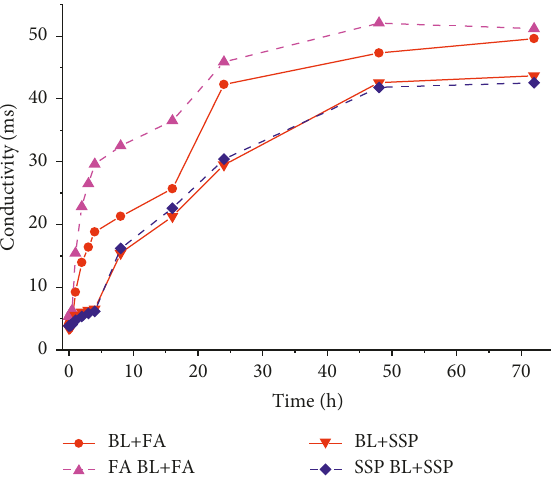
Figure 11: Long-term conductivity changes.